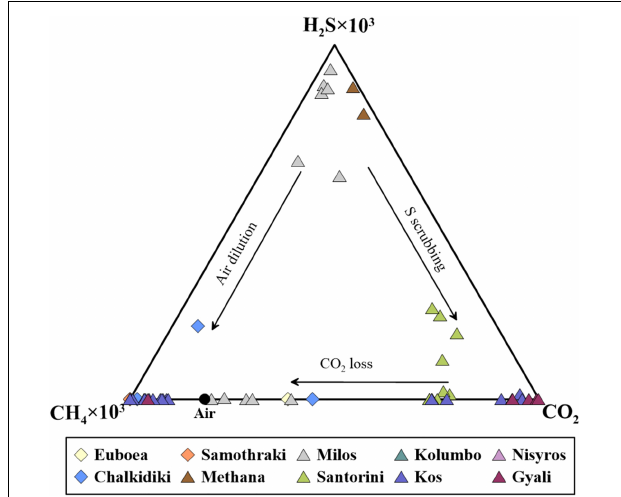
FIGURE 9 | Ternary plot of CO 2 -H 2 S-CH 4 . Processes impacting the gases are drawn with arrows. Values of air after Kipfer et al. (2002). Literature data from Chiodini et al. (1998), Shimizu et al. (2005), Kyriakopoulos (2010), Carey et al. (2013), Tassi et al. (2013), Rizzo et al. (2016, 2019), Daskalopoulou et al. (2018a,b, 2019b, 2021a), and Tarchini et al. (2019).